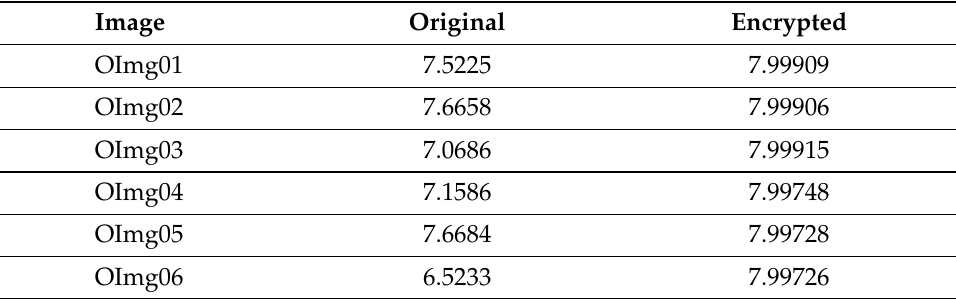
Table 6. Information entropy for original images and their encrypted versions before embedding them onto the reference